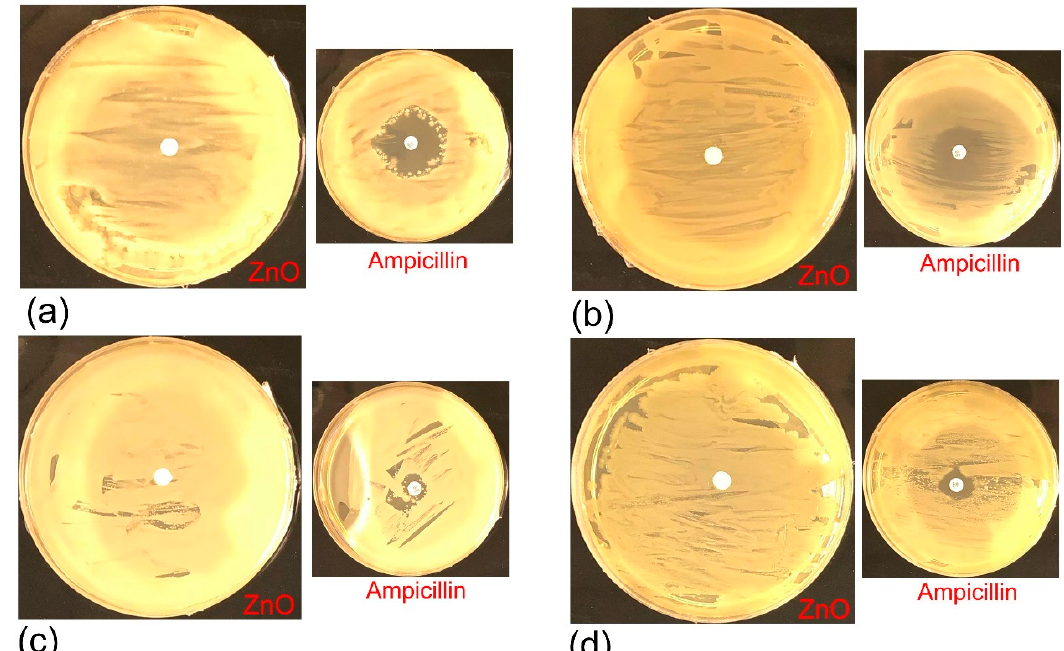
Figure 5. XG-capped ZnO microparticles and Ampicillin against ( a ) Bacillus subtilis ( b ) Bacillus sphaericus ( c ) Bacillus licheniformis and ( d ) Escherichia coli.